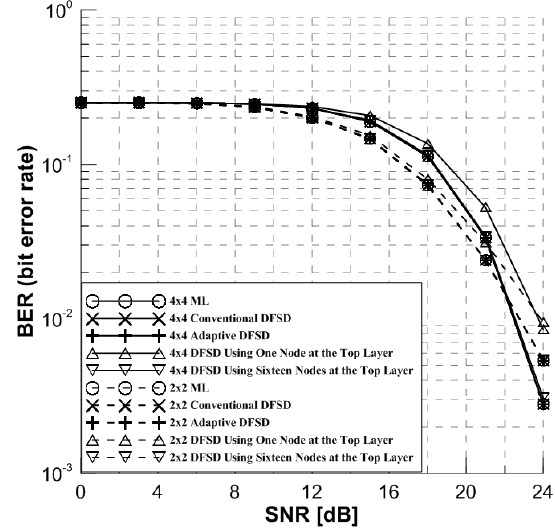
Figure 7. The error performance of the detection schemes with